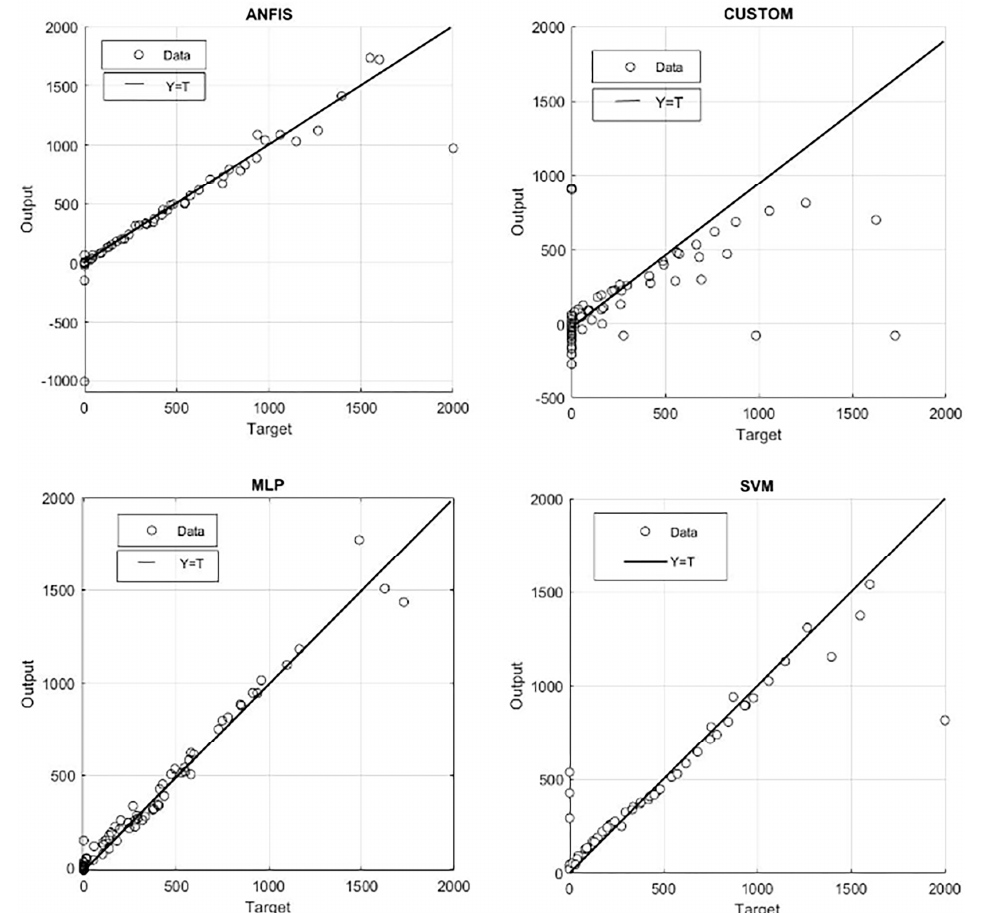
Figure 8. Force simulated (Output) by the ANFIS, custom, MLP, and SVM models in correlation with the force measured by FESTO (Target) for DMSP-20: test phase.